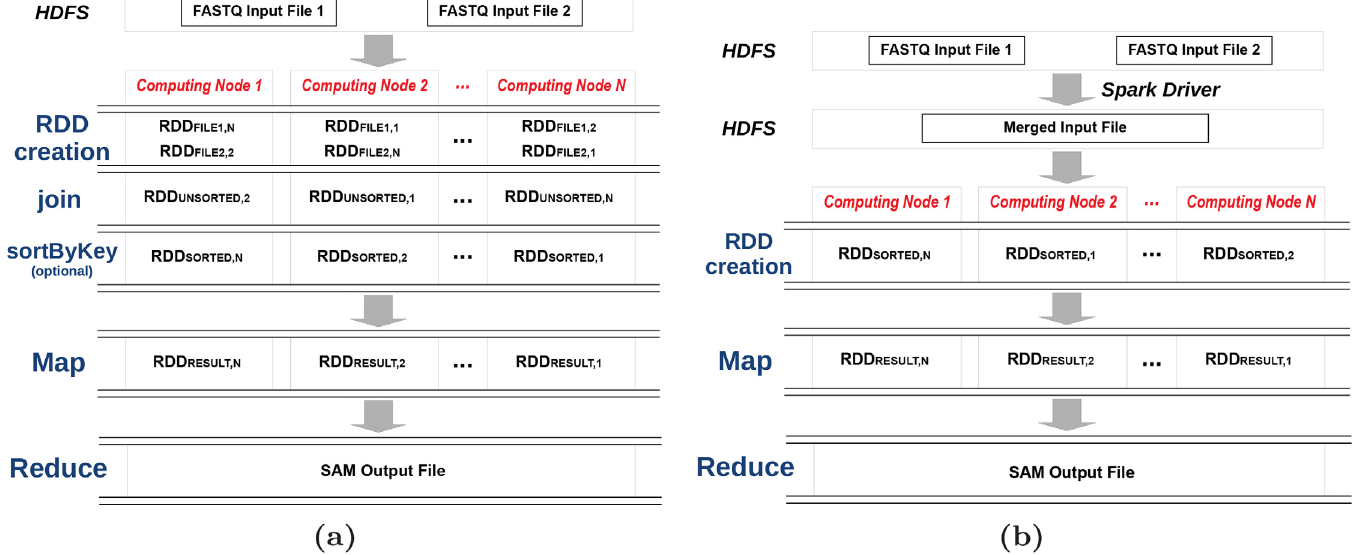
Fig 2. SparkBWA workflow for paired-end reads using (a) Join and (b) SortHDFS